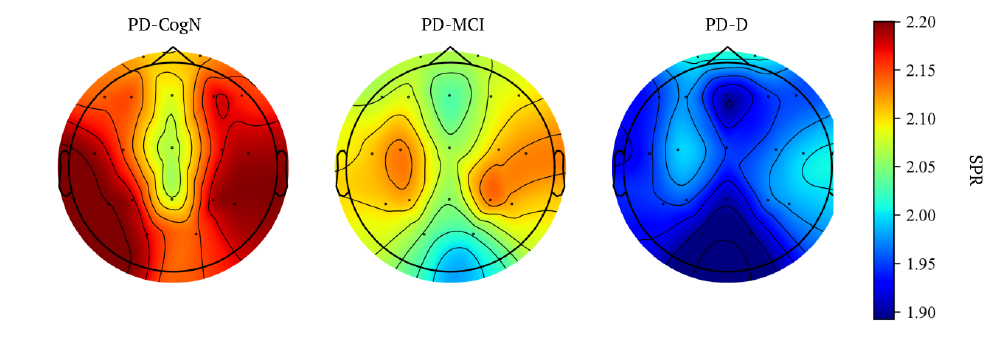
Figure 7. Average topographic maps of SPR in